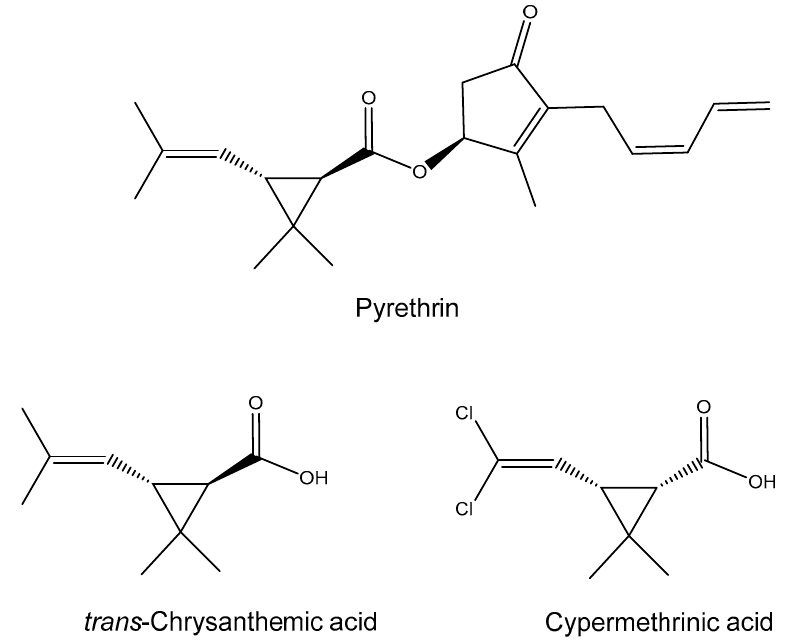
Figure 1. Structures of the most active cyclopropane derivatives.